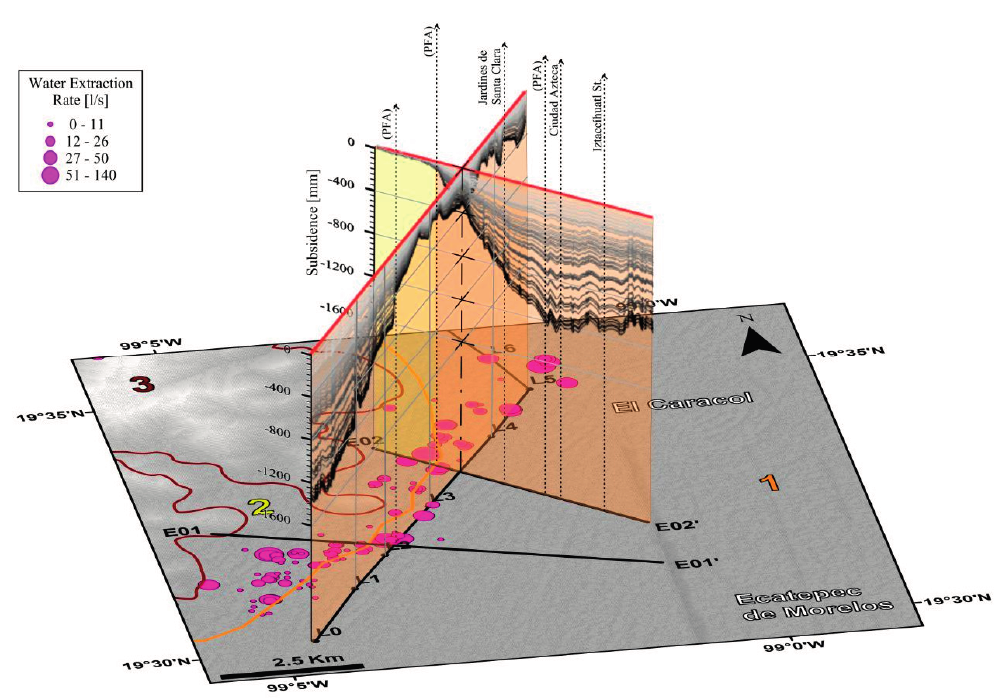
Figure 11. 3D temporal evolution deformation profiles across the Ecatepec de Morelos area. Profile E02-E02 ʹ crosses several sites (dotted lines) reported to be affected by fractures and intersects Section L0–L5 along the TEO structure. Probable fracturing activity (PFA) may develop at the location of displacement jumps. Different materials are denoted with colours (yellow: mainly alluvial deposits; orange: primarily compressible